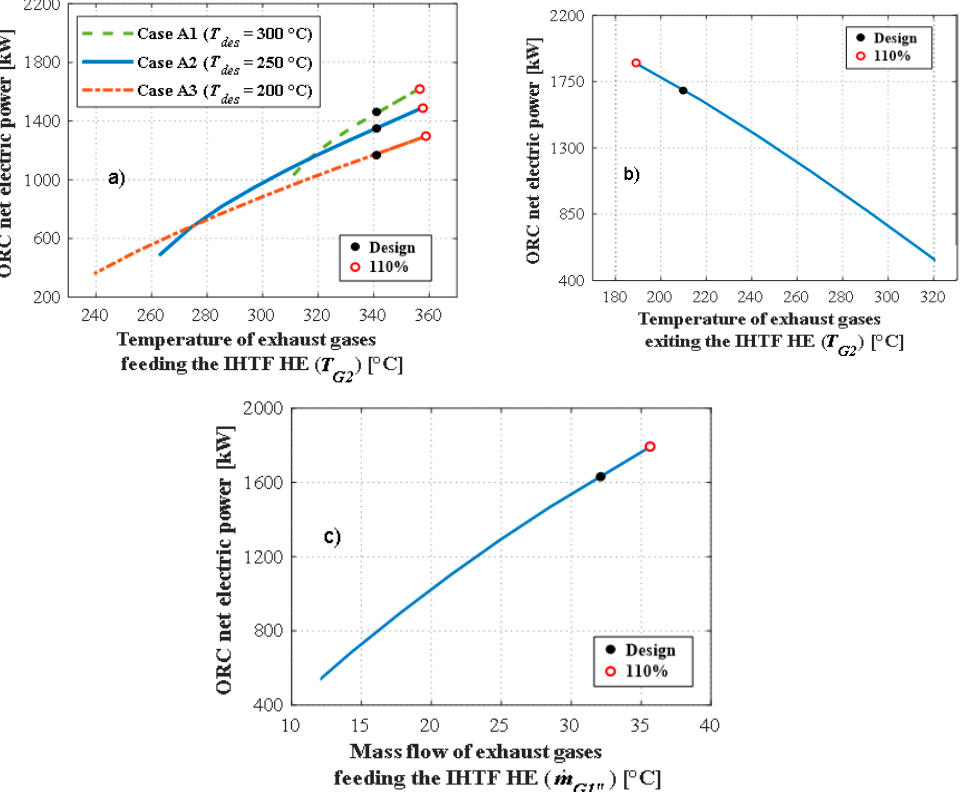
Figure 10. ORC net electric power at part-load conditions: ( a ) effect of gas temperature at IHTF HE inlet, for layout A and different T des values; ( b ) effect of gas temperature at IHTF HE outlet, for layout B; ( c ) effect of gas mass flow.